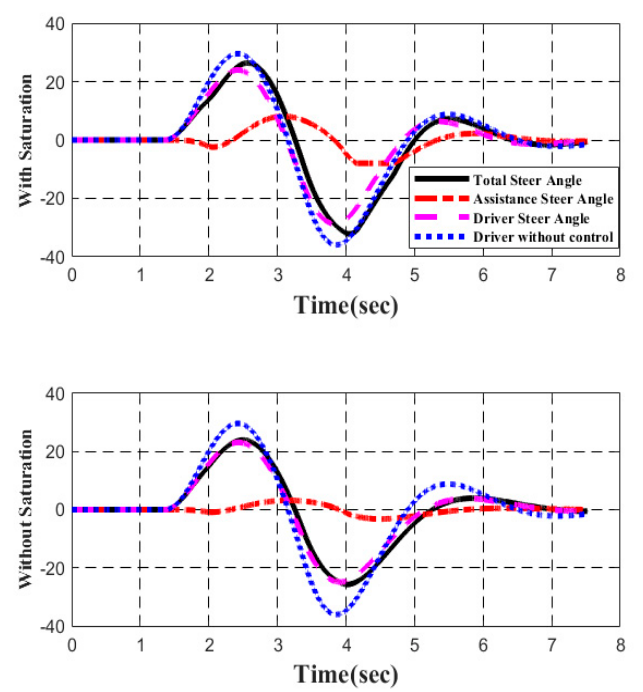
Figure 9. The simulation results for the steering angle.